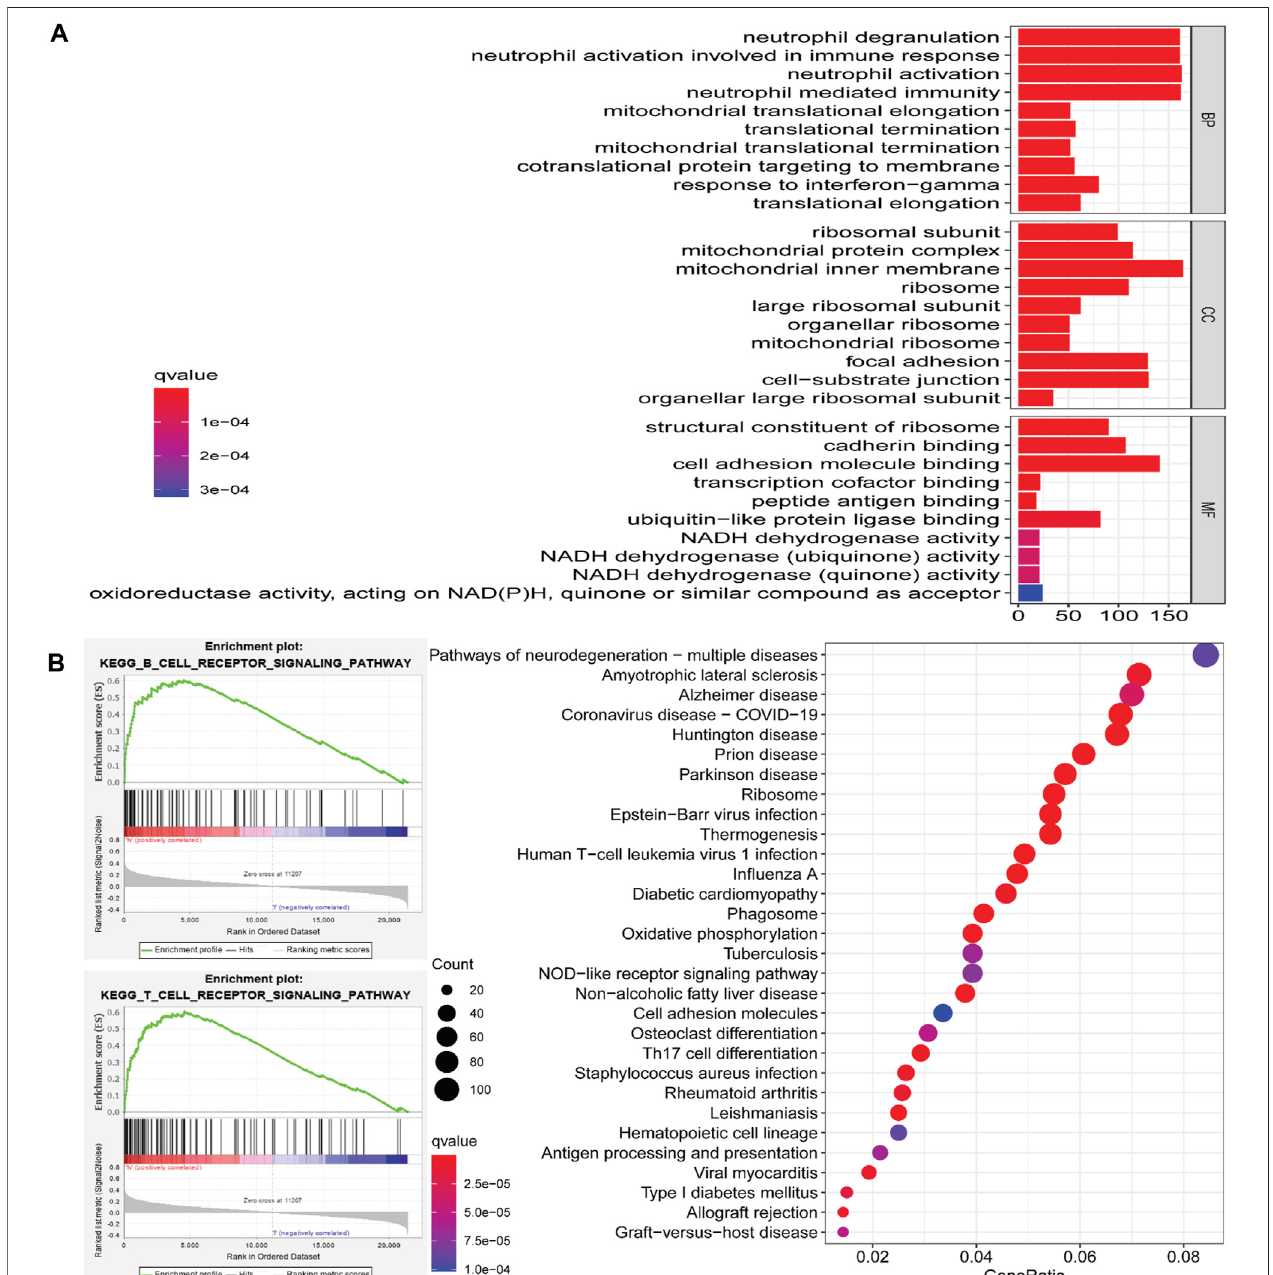
FIGURE3| Go(Geneontology)functionalannotationandKEGG(KyotoEncyclopediaofGenesandGenomes)pathwayenrichmentanalysisofARRDC2inOV. (A) Go functional annotation. Biological Process, BP (neutrophil degranulation, neutrophil mediated immunity, etc.). Cellular Component, CC (ribosomal subunit, mitochondrial protein complex, ribosome, large ribosomal subunit, etc.). Molecular Function, MF (structural constituent of ribosome, cadherin binding, transcription cofactor binding, etc.). (B) KEGG pathway enrichmentanalysis (Bcell receptor signaling pathway, Tcellsignaling pathway, Human T-cellleukemiavirus1infection signalingpathway,NOD-Likereceptorsignalingpathway,Th17celldifferentiation,etc.).GSEAenrichmentanalysisresultsofARRDC2(Bcellreceptorsignalingpathway and T cell signaling pathway).